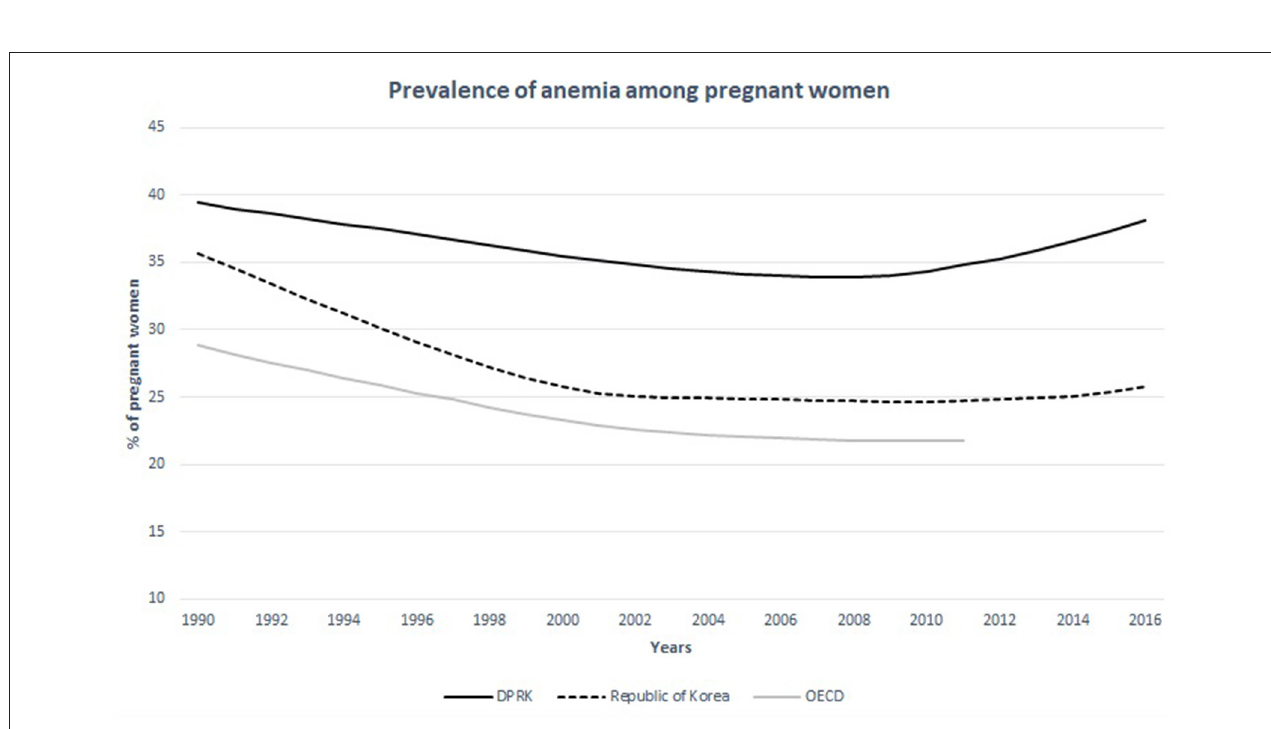
FIGURE 5 | Infant mortality ratio of the DPRK in comparison with the Republic of Korea and the nations of OECD between 1990 and 2015. Source: United Nations Inter-agency Group for Child Mortality Estimation (UNICEF, WHO, World Bank, UN DESA Population Division) at childmortality.org.